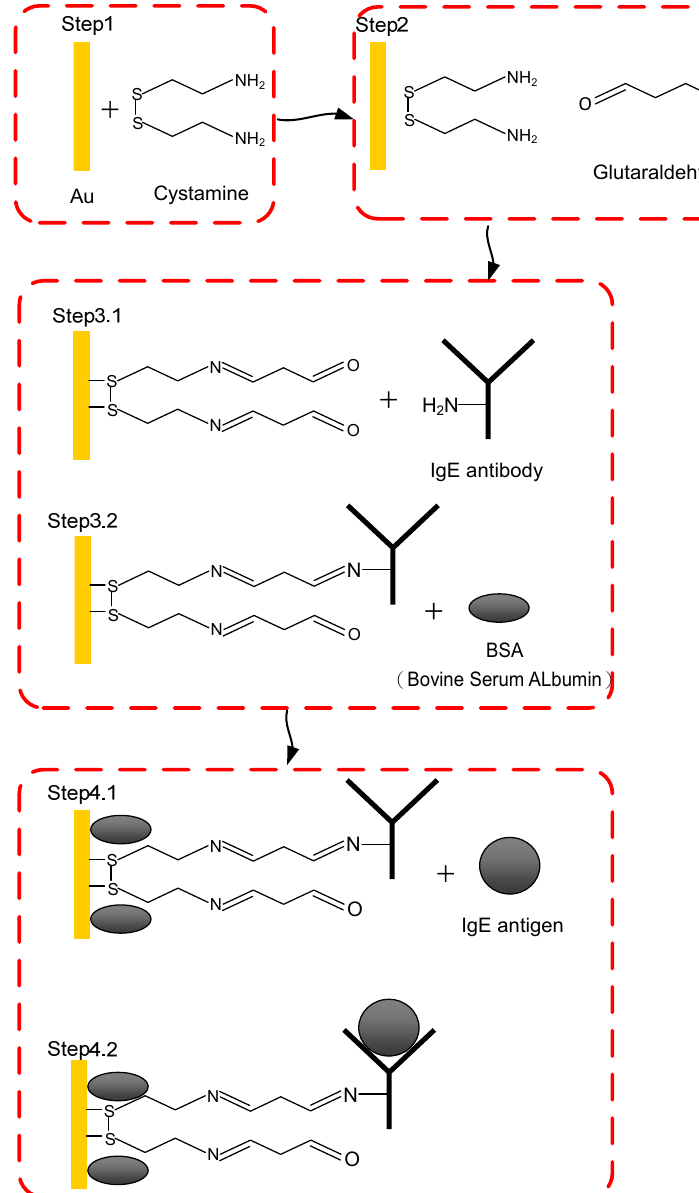
Figure 5. Schematic diagram of the integration of cystamine SAM, glutaraldehyde and IgE antibody/antigen in